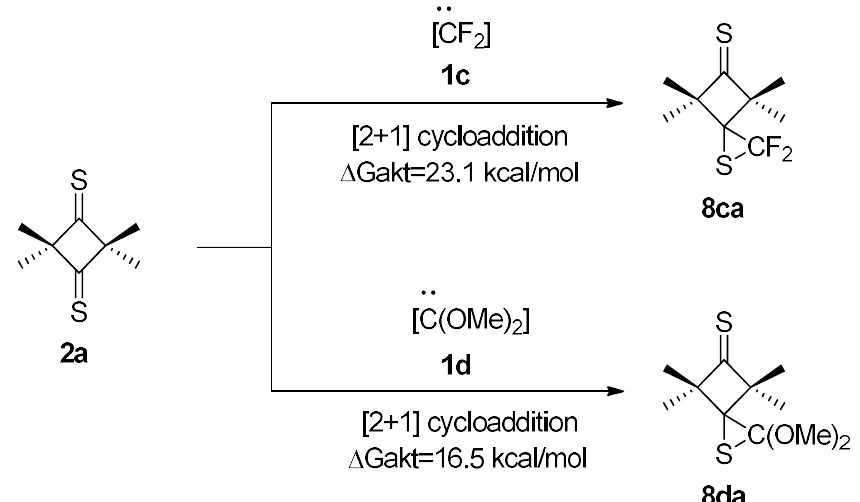
Figure 7. Views of the TS structure for 1 a + 2b → 10ab transformation in the reaction starting with carbene 1a and thioketone 2b in the light of wb97xd/6-311g(d,p)(PCM) computational study. Finally, additions of nucleophilic carbenes 1c and 1d to thioketone 2a were also ana- lyzed (Scheme